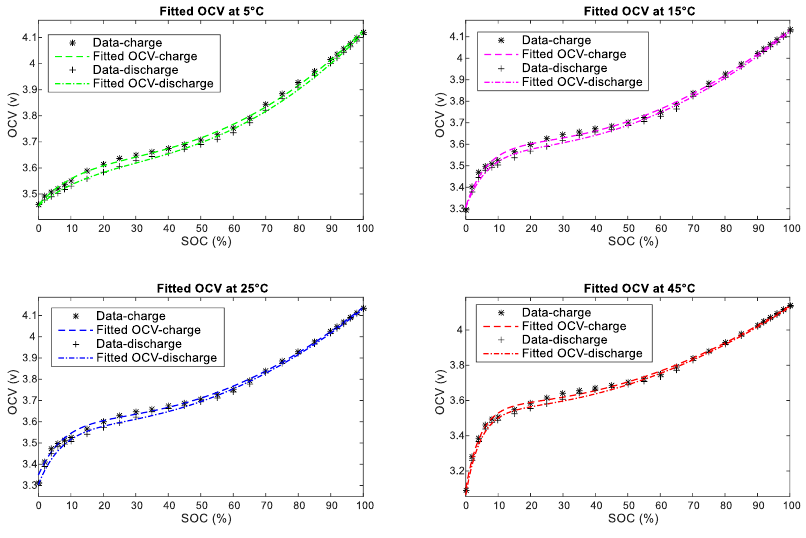
Figure 10. OCV fitting results of the proposed model at different temperatures in charge and discharge. All of the fitted parameters of the proposed model are presented in Table